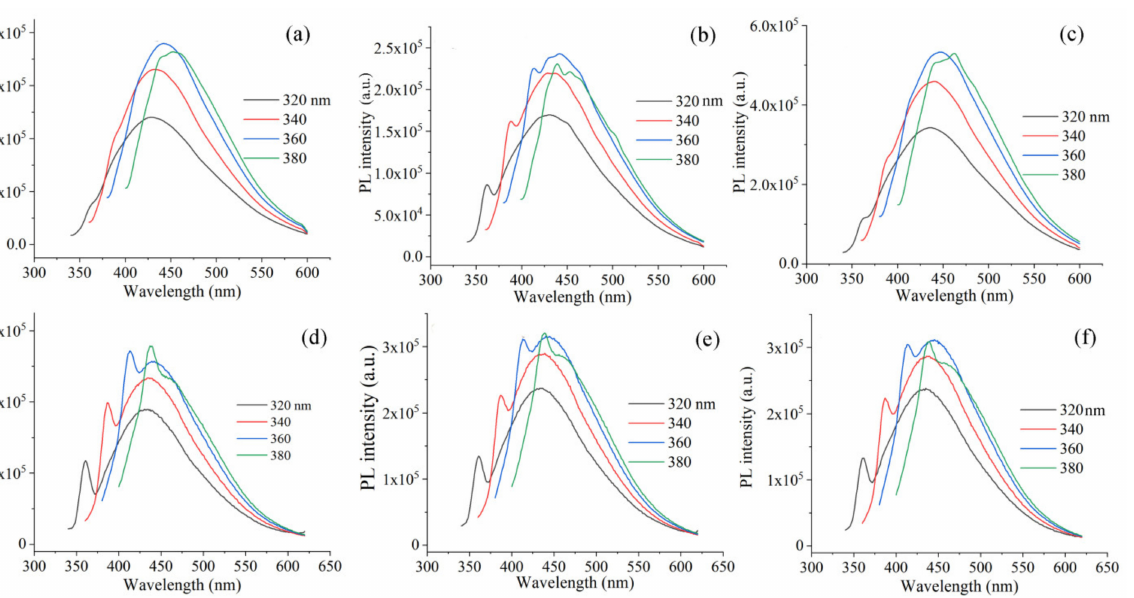
Figure 5. PL spectra of 25 GQD IPA -EDA ( a ), 50 GQD IPA -EDA ( b ), 200 GQD IPA -EDA ( c ), 200 GQD-1EDA ( d ), 200 GQD-5EDA ( e ), and 200 GQD-10EDA ( f ) recorded at excitation wavelengths of 320, 340, 360, and 380 nm.